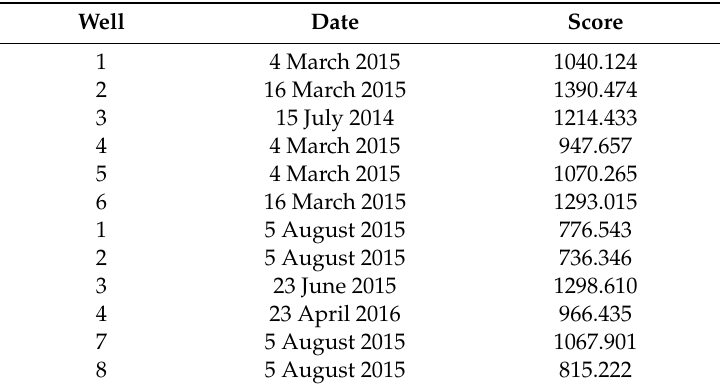
Table 6. Comprehensive score of produced water from typical